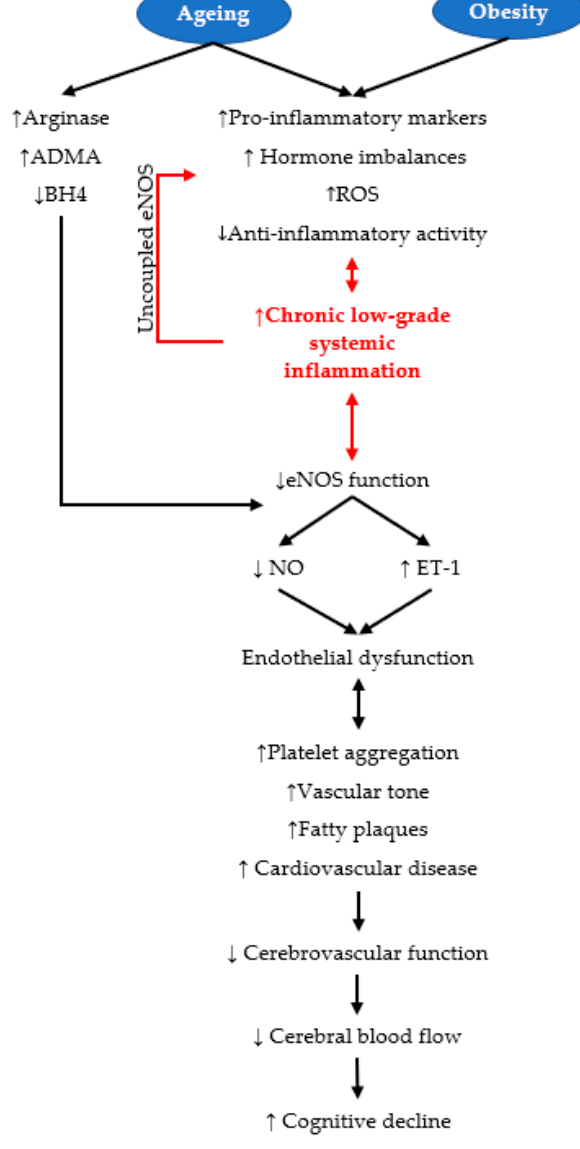
Figure 2. The effect of ageing and obesity on endothelial dysfunction, leading to cognitive decline. Obesity and ageing increase the production of inflammatory markers, including tumour necrosis factor-alpha (TNF- α ), and interleukin-6 (IL-6) and decrease anti-inflammatory mediators [66,76]. Increased reactive oxygen species (ROS) occurs in obesity and ageing, further promoting chronic low-grade systemic inflammation [68,76,84]. Ageing also reduces the endothelial nitric oxide synthase (eNOS) cofactor, tetrahydrobiopterin (BH4), and increases asymmetrical dimethylarginine (ADMA), which decreases nitric oxide (NO) synthesis and bioavailability [68]. Increased arginase activity reduces L-arginine supply, thus also promoting the uncoupling of eNOS [53]. Increased vasoconstrictors, such as endothelin-1 (ET-1), contribute further to increased vascular tone and endothelial dysfunction [67]. Uncoupled eNOS creates further ROS instead of NO, exacerbating endothelial dysfunction [61]. These mechanisms lead to low-grade systemic inflammation and ED, leading to increased platelet aggregation, vascular tone and fatty plaques leading to cerebrovascular dysfunction, thus reducing cerebral blood flow and cognition [85]. Abbreviations: ↑ : increased; ↓ :